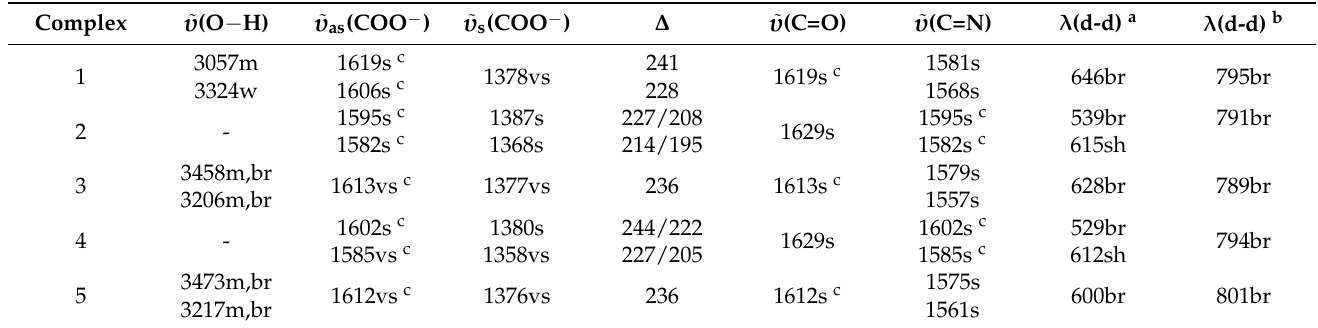
Table 1. Infrared (in cm −1 ) and electronic (in nm) data of complexes 1 – 5 .